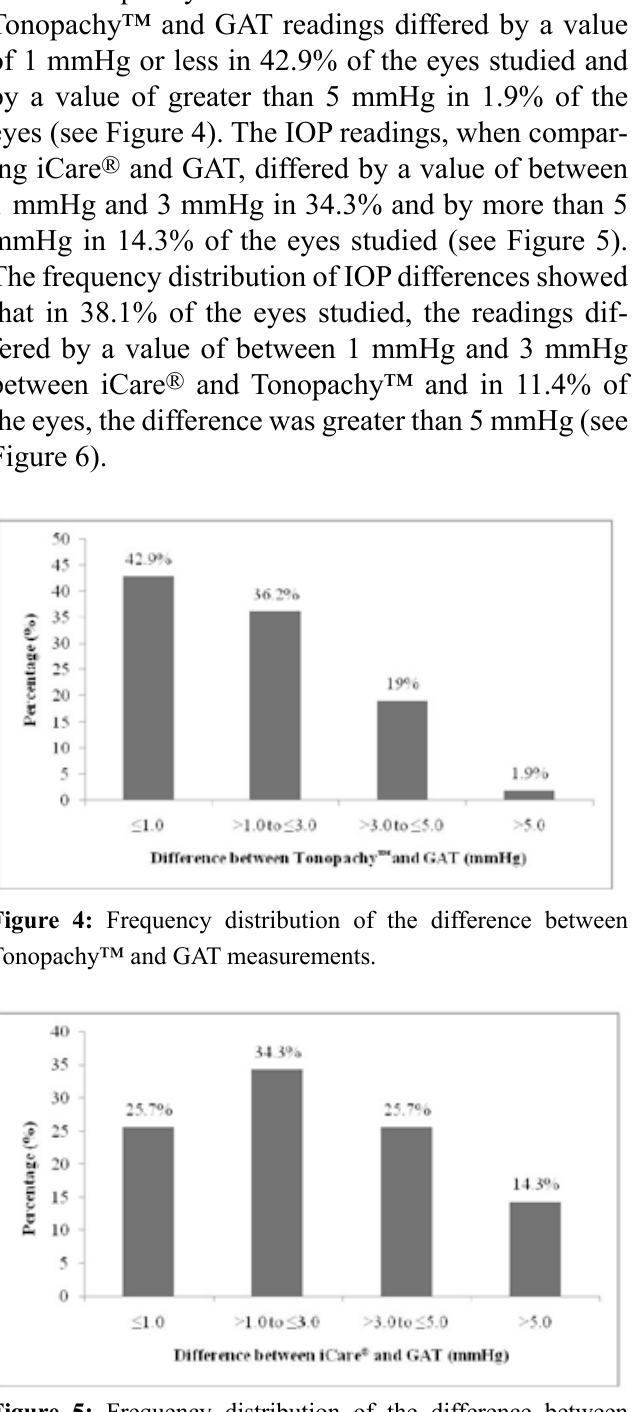
Figure 5: Frequency distribution of the difference between iCare ® and GAT measurements.